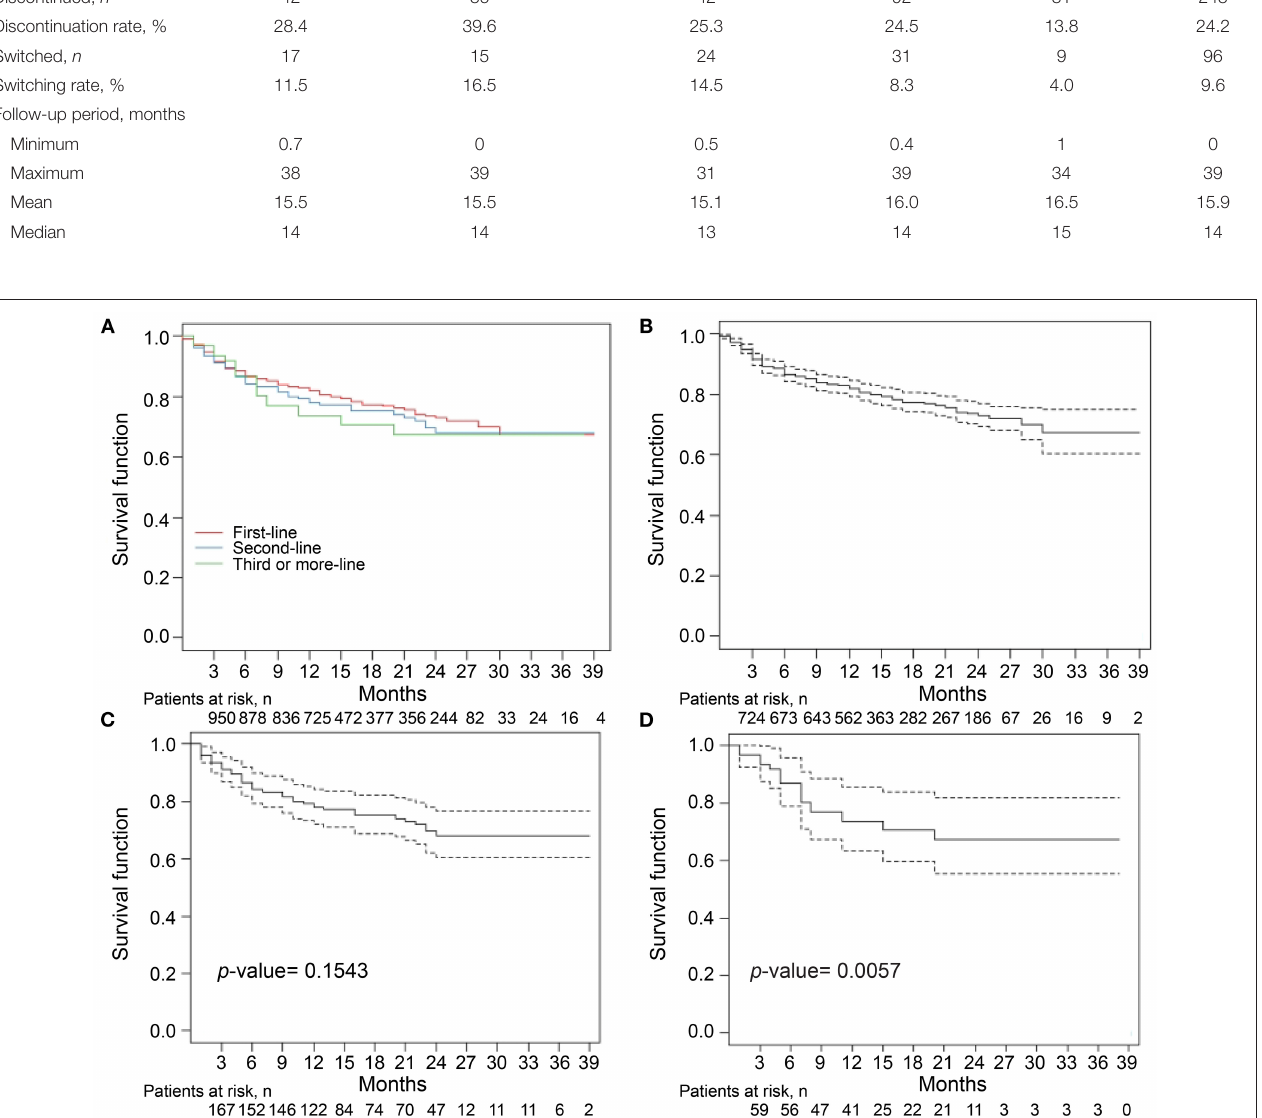
FIGURE 1 | Drug retention rates for tumor necrosis factor inhibitors (TNFi) in patients with ankylosing spondylitis (AS) (A) . The median follow-up period was 14 months. The overall drug retention rate for TNFi was 75.8%. Estimate of the drug survival function showed that the adjusted hazard ratio (HR) for third-time